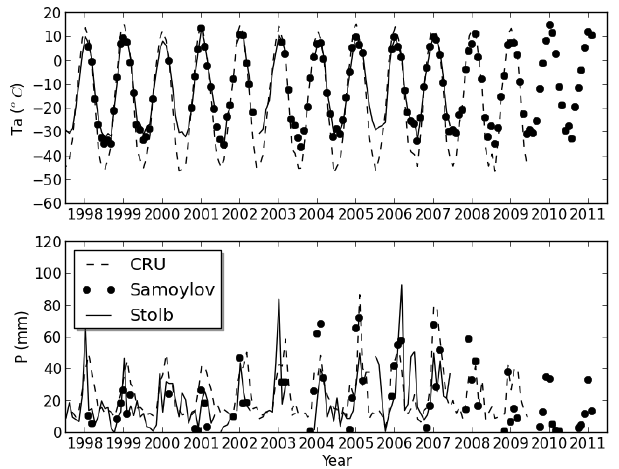
Figure 2. Monthly air temperature ( T a ) and precipitation ( P ) mea- surements from Samoylov Island (Samoylov), from the Stolb mete- orological station (Stolb), and from the CRU’s global data